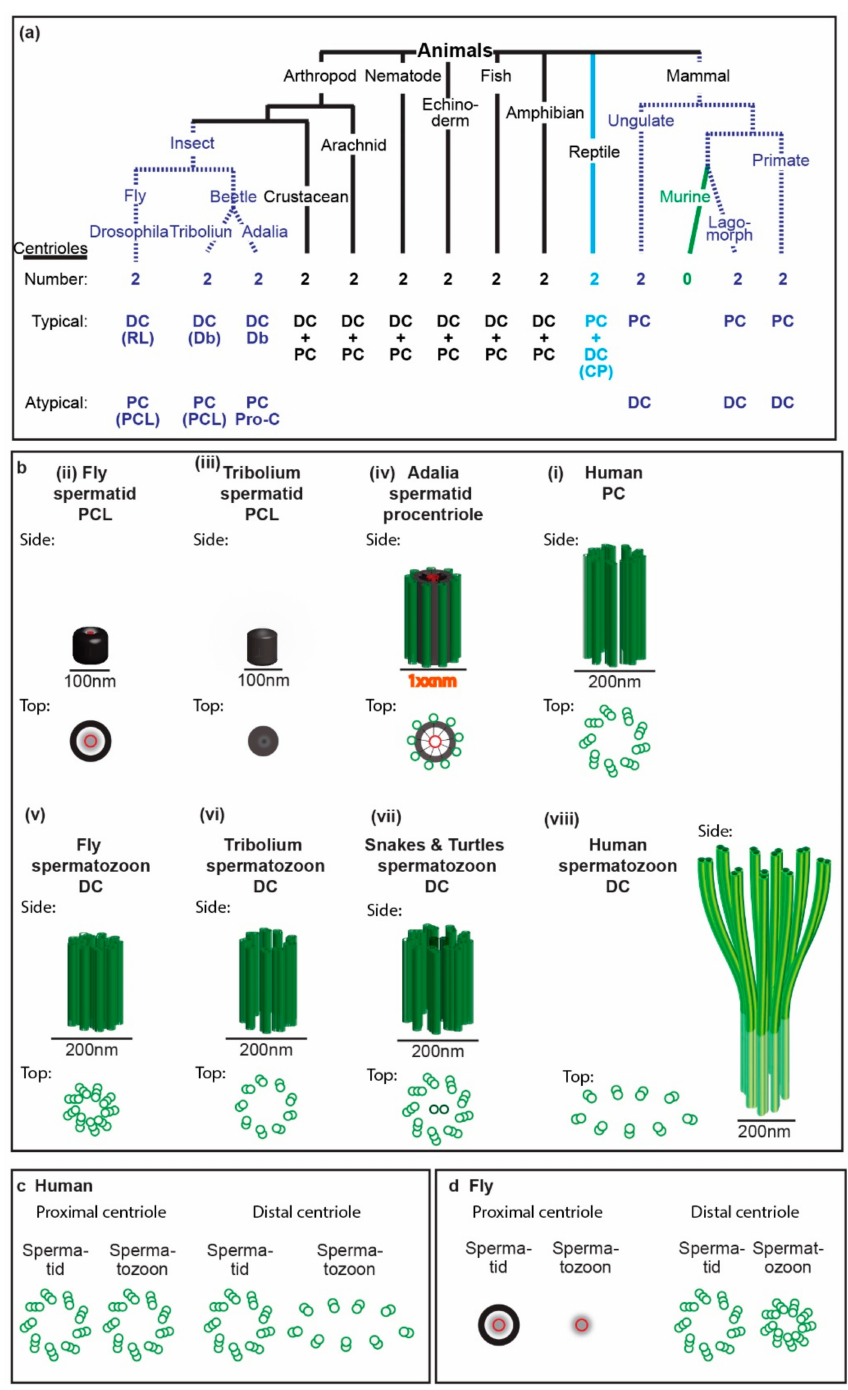
Figure 2. Spermatozoon typical and atypical centrioles have diverse structures in animals. ( a ) Phylogenetic tree with representative animal groups. Number of centrioles (first row), which centriole is typical and atypical (second and third rows, respectively), and type of centrioles as well as their modifications (in parenthesis) are indicated; RL, reduced diameter of the centriole lumen; Db, nine doublets of microtubules instead of triplets; PCL, proximal centriole-like structure as depicted in panel “b” or “d”; Pro-c, procentriole; CP, centriole with central pair. ( b ) Models of spermatid and spermatozoa proximal and distal centriole. The centrioles are depicted from side and top views and are to scale. ( c , d ) The structural differences between spermatid centrioles and spermatozoa centrioles in human ( c ) and fly ( d